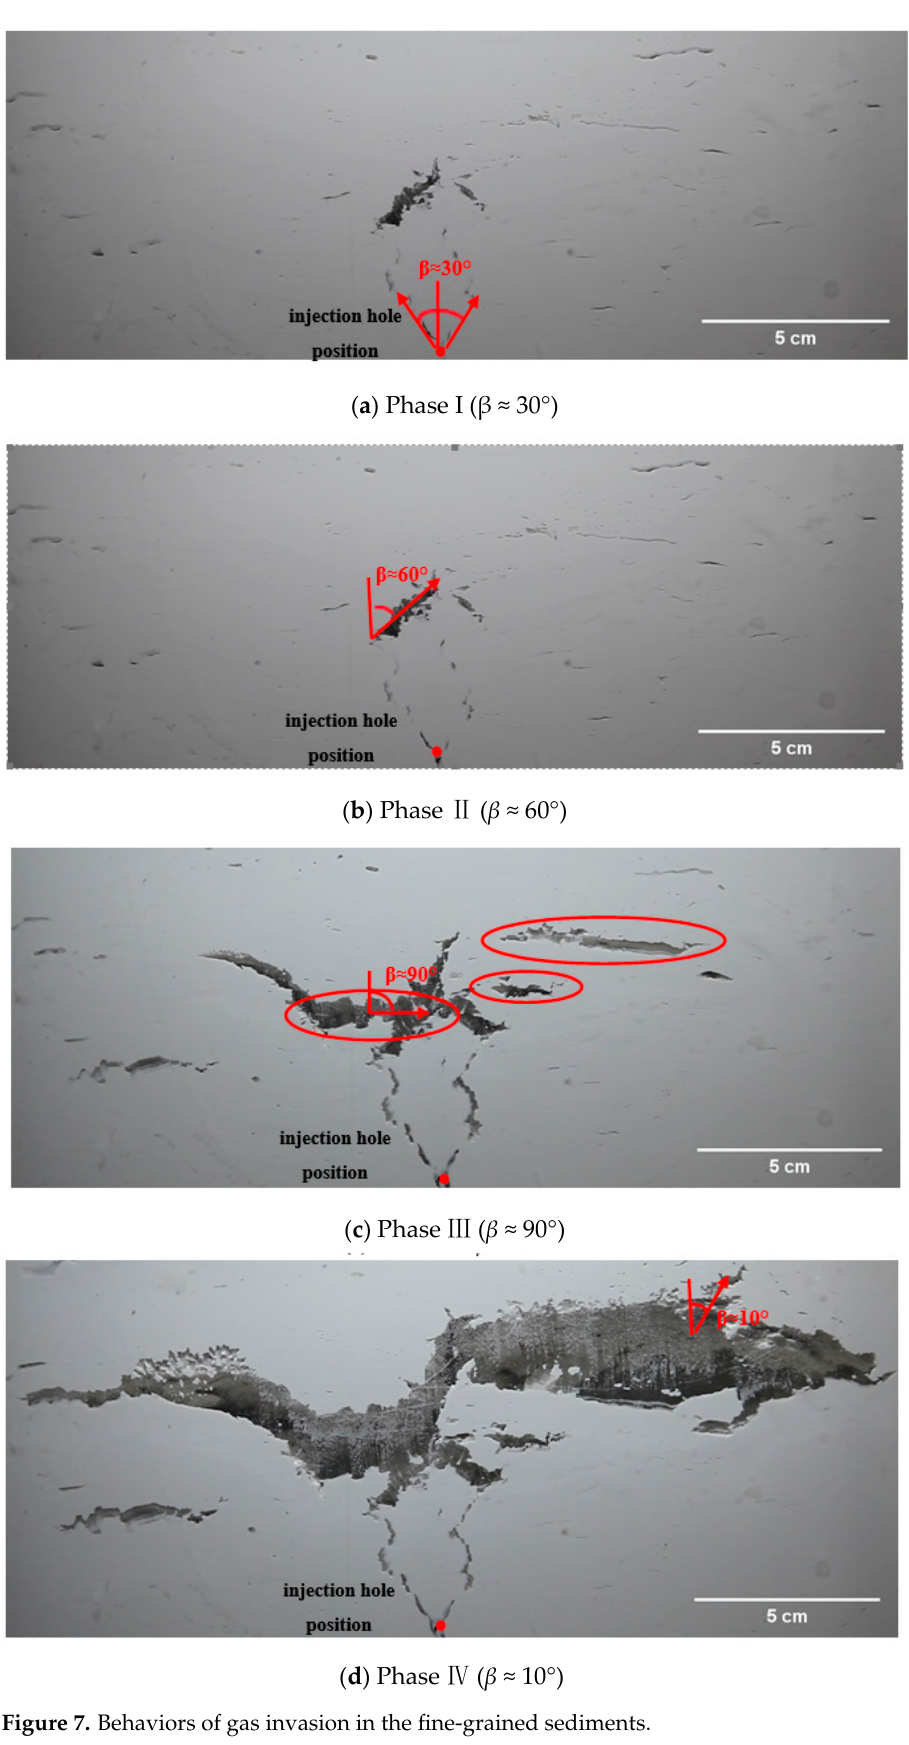
Figure 7. Behaviors of gas invasion in the fine-grained sediments.